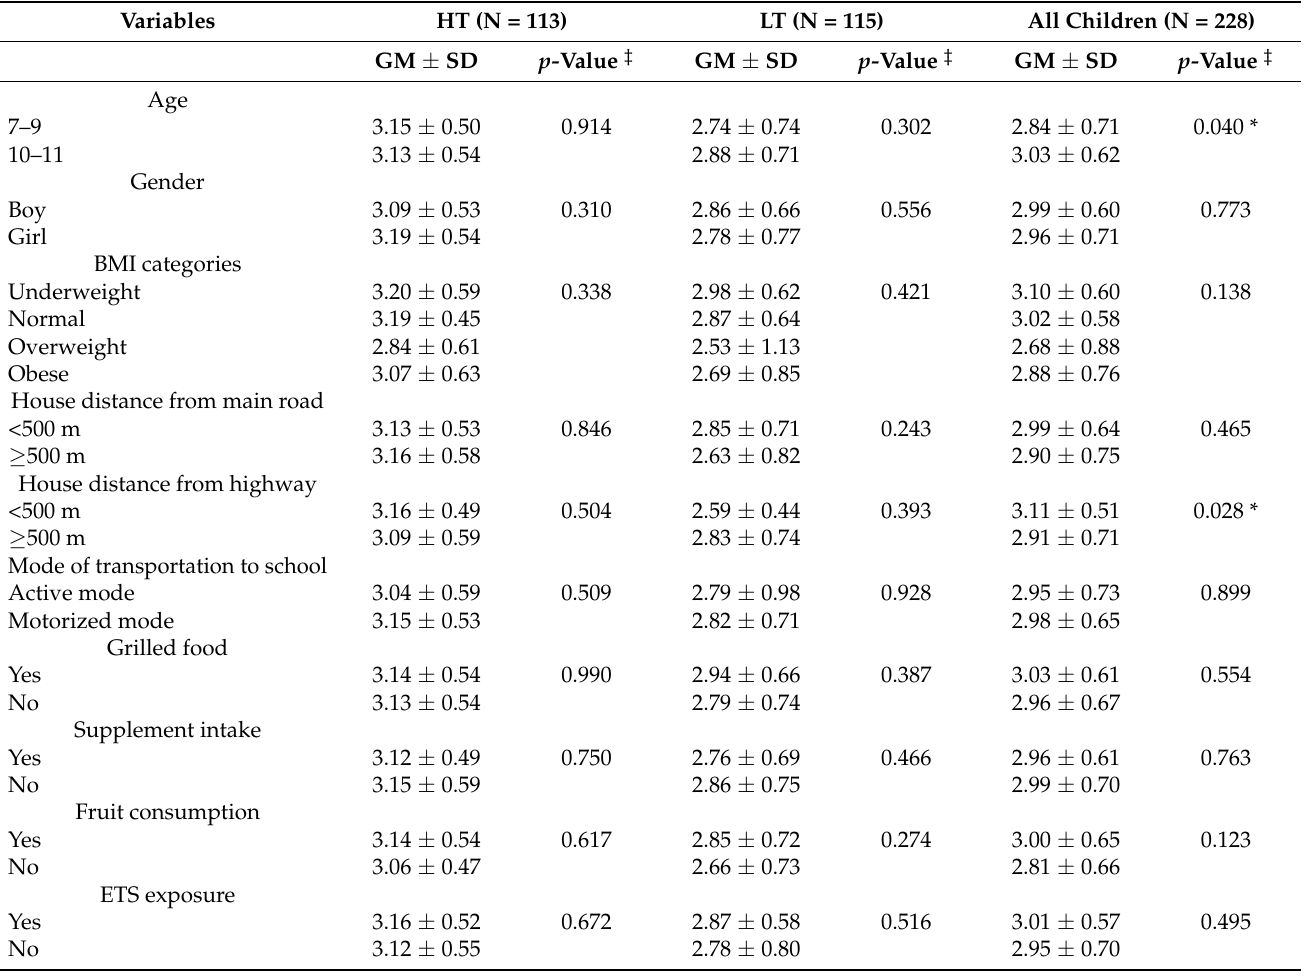
Table 2. Comparison of Tail Moment according to a different individual